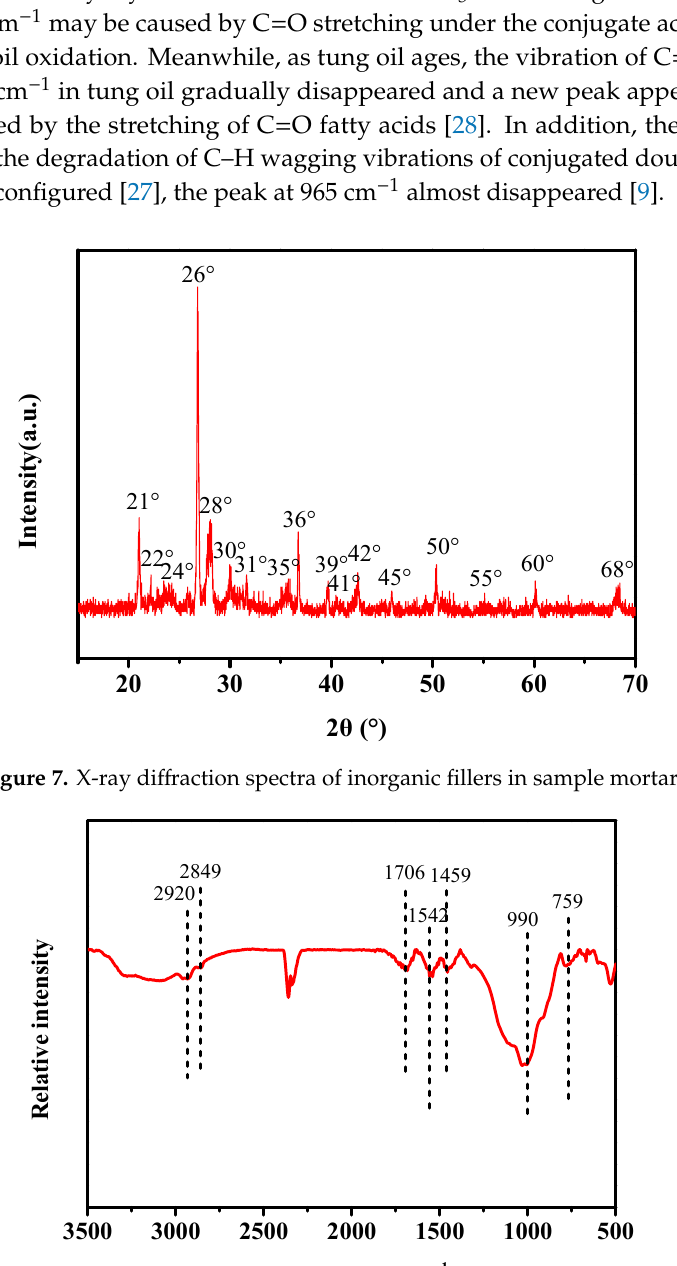
( b ) Figure 6. ( a ) Photo of untreated ramie fibers under a polarizing microscope at 20×; ( b ) photo of ramie fibers under a polarizing microscope at 20× and treated with Herzberg stain. The X-ray diffraction results of the mortar shown in Figure 7 indicate that there were peaks at 2θ values of 21°, 26°, 36°, 39°, 41°, 42°, 45°, 50°, 55°, 60°, and 68°, respectively, coinciding with the diffraction peaks of the mineral gismondine (CaAl 2 Si 2 O 8 ·4H 2 O; JCPDS 20–0452). The peak at 28° was